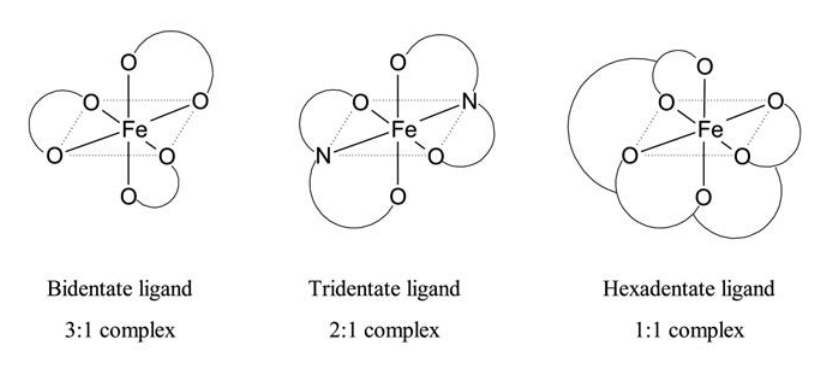
Figure 2. Simple iron chelators.